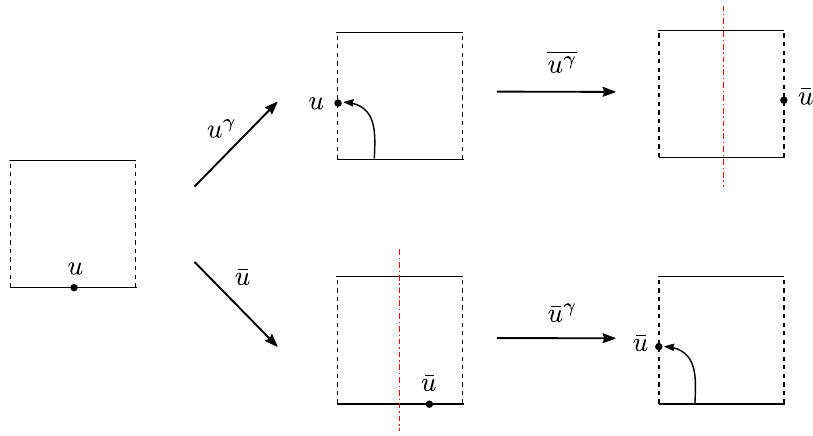
Figure 22 . Noncommutativity of the mirror transformation and the parity transformation. The red dashed line denotes the re(cid:13)ection axis for the parity transformation. If we (cid:12)rst perform the mirror transformation and then perform the parity transformation, we follow the upper path and the particle ends up on the right edge. On the other hand, if we perform the transformations in the opposite order, the particle ends up on the left